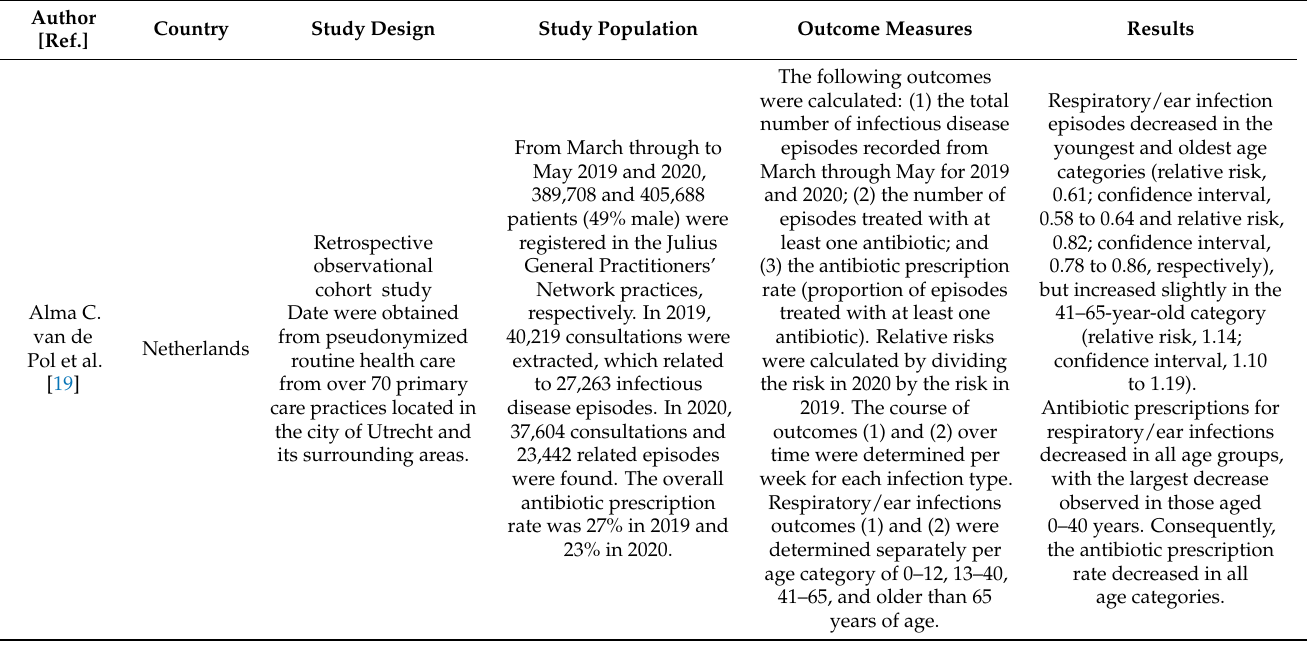
Table 3. Summary of studies on antibiotic prescriptions for OM during the COVID-19